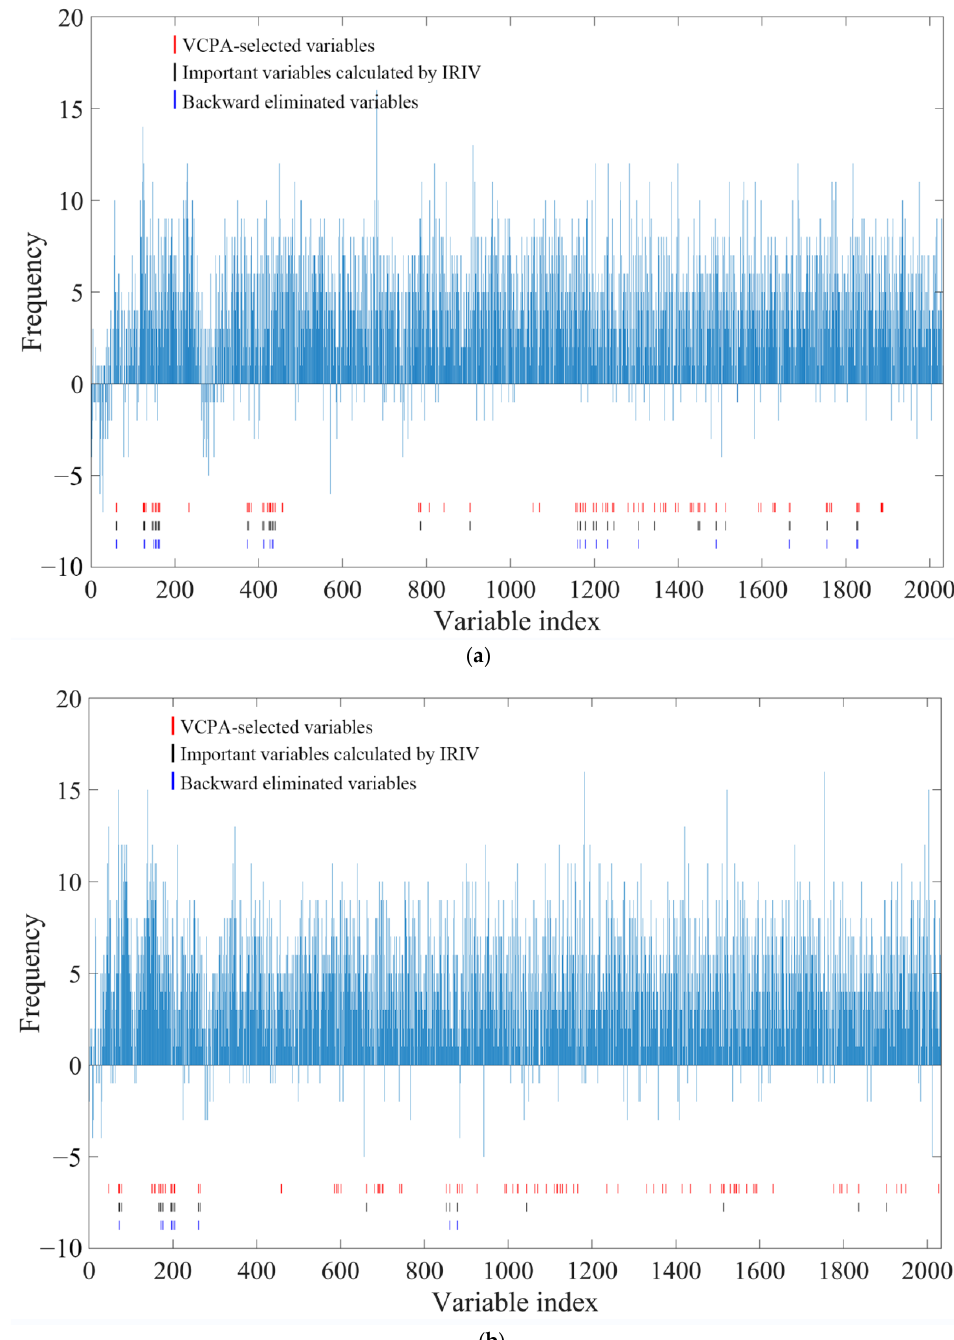
Figure 6. VCPA-IRIV variable selection on dataset ( a ) geniposide; ( b ) baicalin.